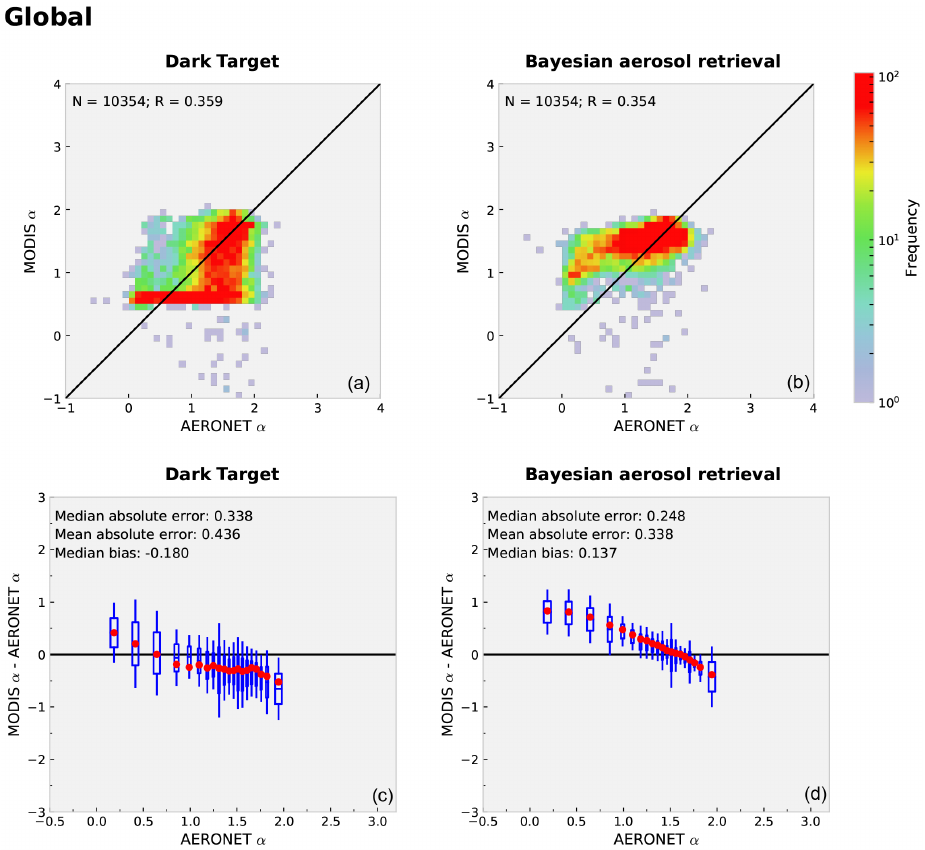
Figure 6. (a, b) Scatter density histograms comparing global AERONET and MODIS Dark Target (a) and MODIS Bayesian aerosol re- trieval (b) Ångström exponent retrievals. The solid black line represents the 1 : 1 line. (c, d) The retrieval error for MODIS Dark Target (c) and MODIS Bayesian aerosol retrieval (d) retrievals plotted as function of AERONET Ångström exponent. The red dots and horizontal lines inside the boxes represent the median and mean values of MODIS Ångström error. The box height and whiskers represent the 1 − σ and 2 − σ intervals of the MODIS Ångström retrieval error. The width of the box corresponds to the 1 − σ of Ångström exponent bin. Table 6. Global and regional statistics of AOD retrievals for Deep Blue (DB) and Bayesian aerosol retrieval (BAR) algorithms. All pixels are considered. Bolded numbers indicate the algorithm with better